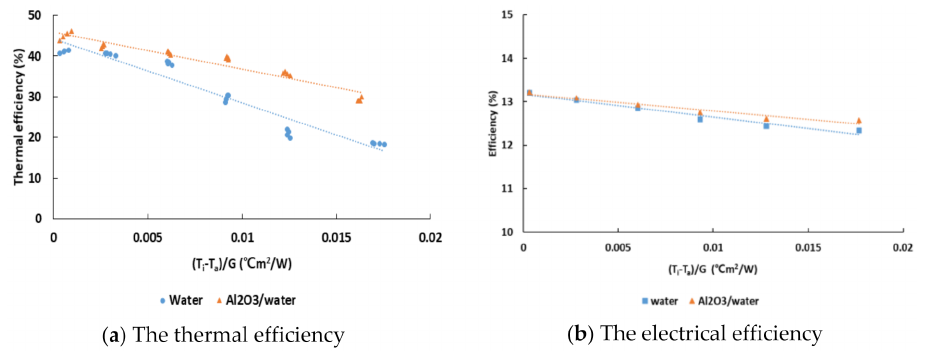
Figure 6. The efficiency of the PVT system using water and Al 2 O 3 -water nanofluid according to (T i − T a )/G, where ( a ) shows the thermal efficiency while ( b ) shows the electrical efficiency. Mohammad et al. [9] investigated the effects of Al 2 O 3 -water nanofluid in the PVT system from the energy viewpoint. They reported results of 36.66% and 13.44% for electric and thermal energy efficiency, which is slightly higher than 35.96% and 12.49% in our results. As a neglected aspect of this study, energy is required for pumping fluid into the PVT